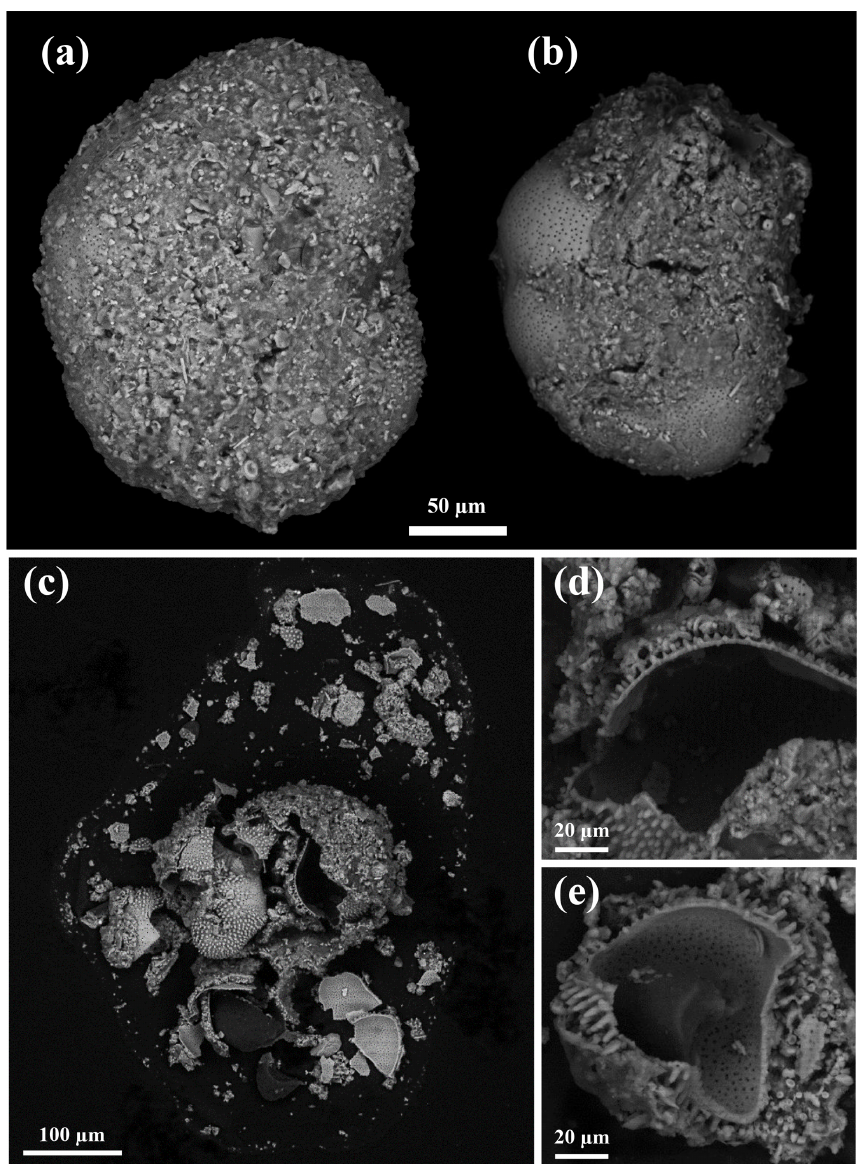
Figure 2. SEM images of fully encrusted specimen (a) , partially encrusted specimen (b) and crushed encrusted specimen of Elphidium magellanicum (c) . Note the thinness of the crust and the spinose structures in (d) and (e)